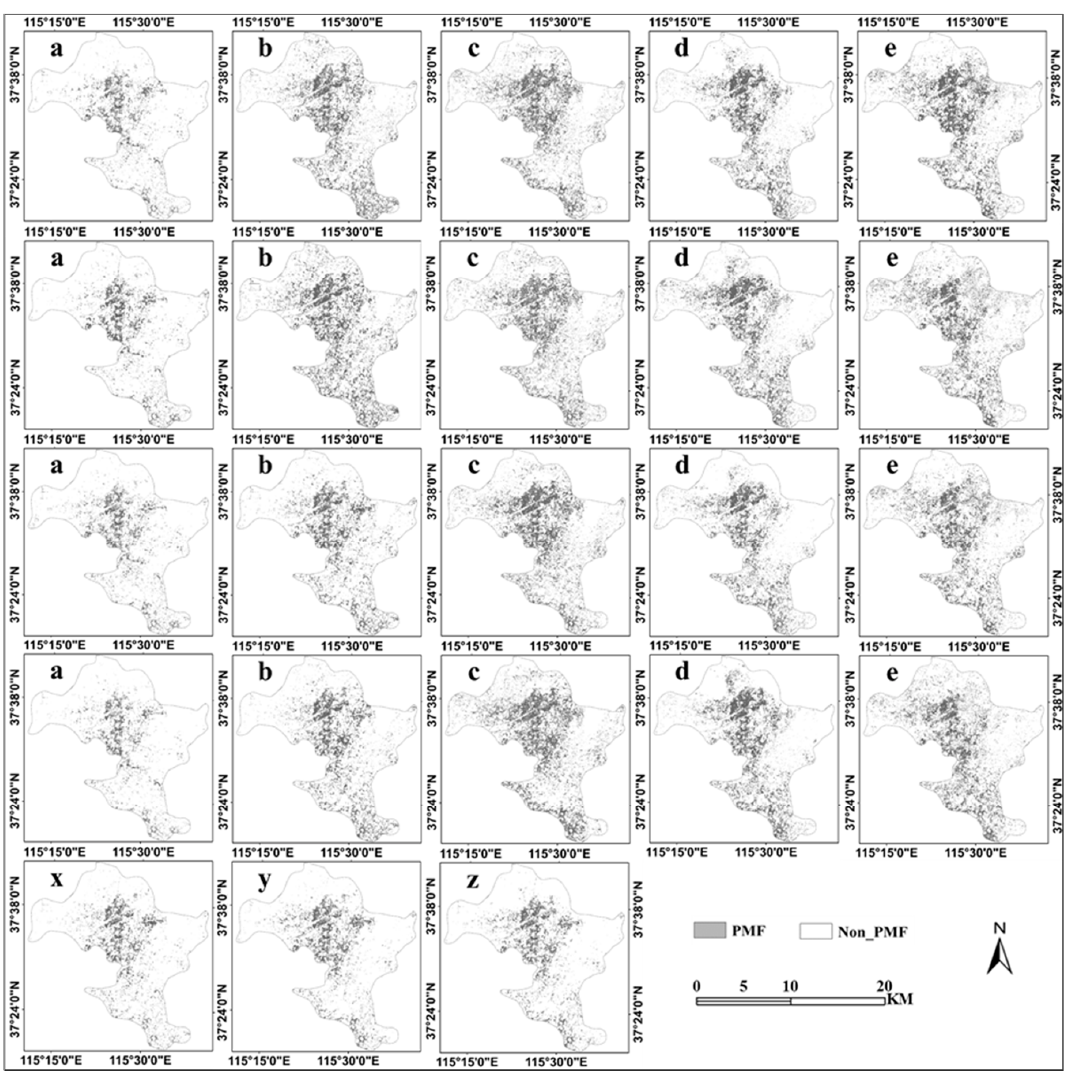
Figure 8. Spatial distribution of PMF in Jizhou using the SVM feature selection and SVM classifier. The first line represents the results from spectral reflectance features, the second line represents the result from the textural features, the third line represents the results from the total features, the fourth line represents the results from the optimized features, and the fifth line represents the results from optimal temporal combined features. ( a ) 2015.04.16; ( b ) 2015.05.18; ( c ) 2015.06.03; ( d ) 2015.06.19;